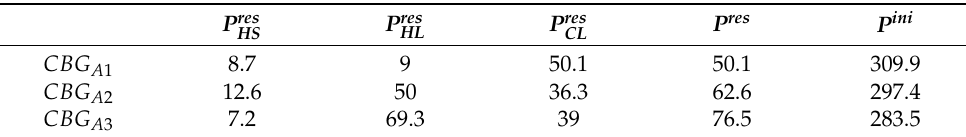
Table 2. Power reserve analysis for each CBG